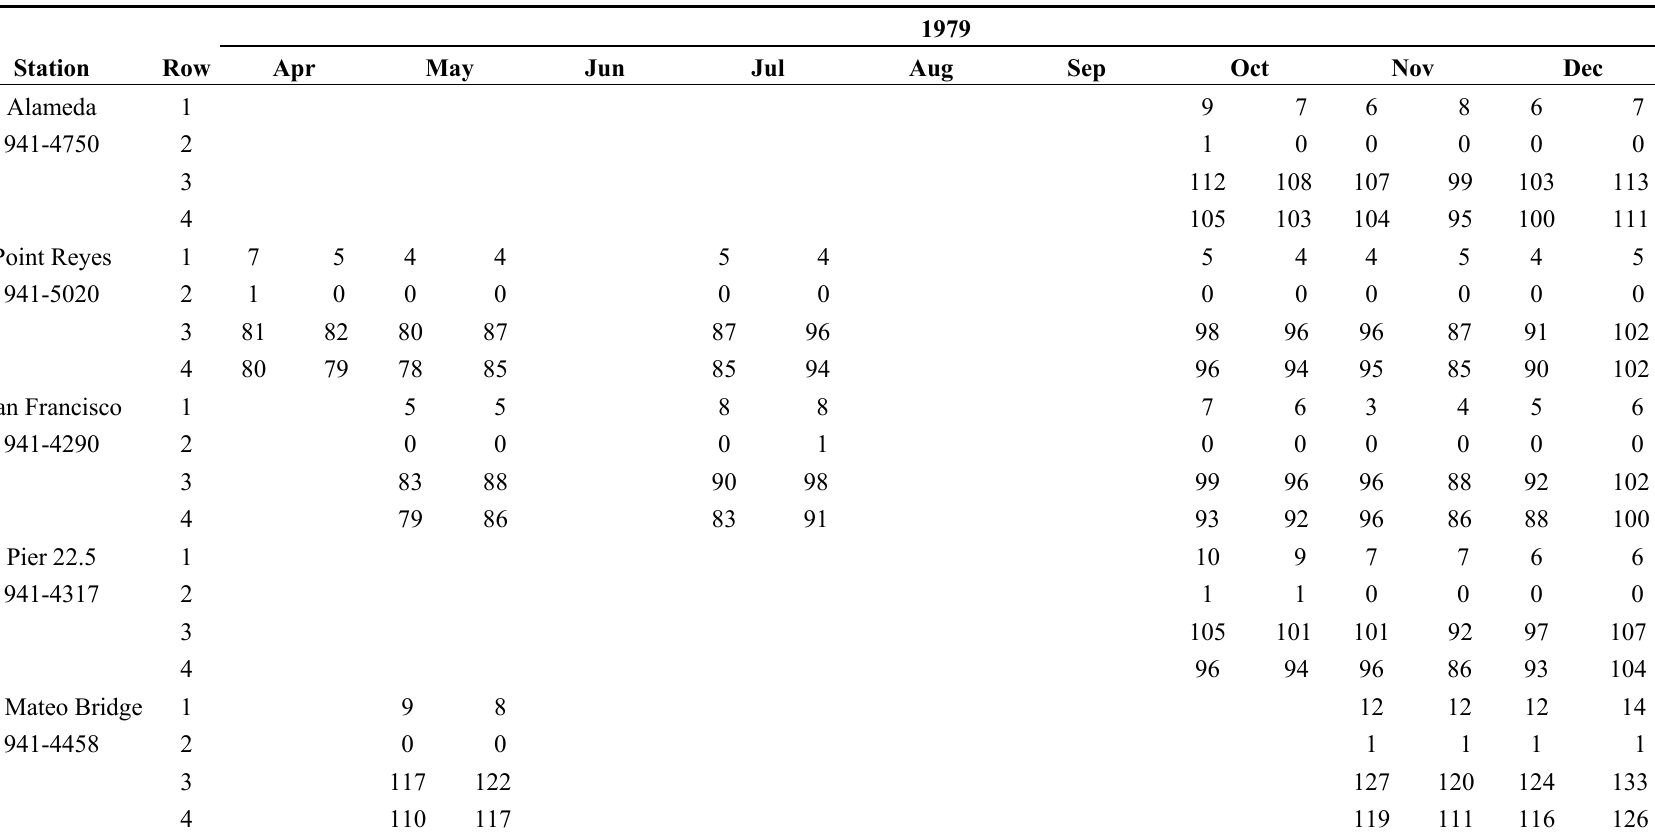
Table 9. Water Surface Elevation Hindcast Validation: April 1979–October 1980. For each box, the first column of values corresponds to the first 15 days of the month, with the second column denoting the remaining portion of the month. Within each column: Row 1 corresponds to the RMSE in cm. Row 2 corresponds to the Willmott Relative Error in percent. Row 3 corresponds to the model mean in cm relative to MLLW. Row 4 denoting the observed water level mean in cm with respect to